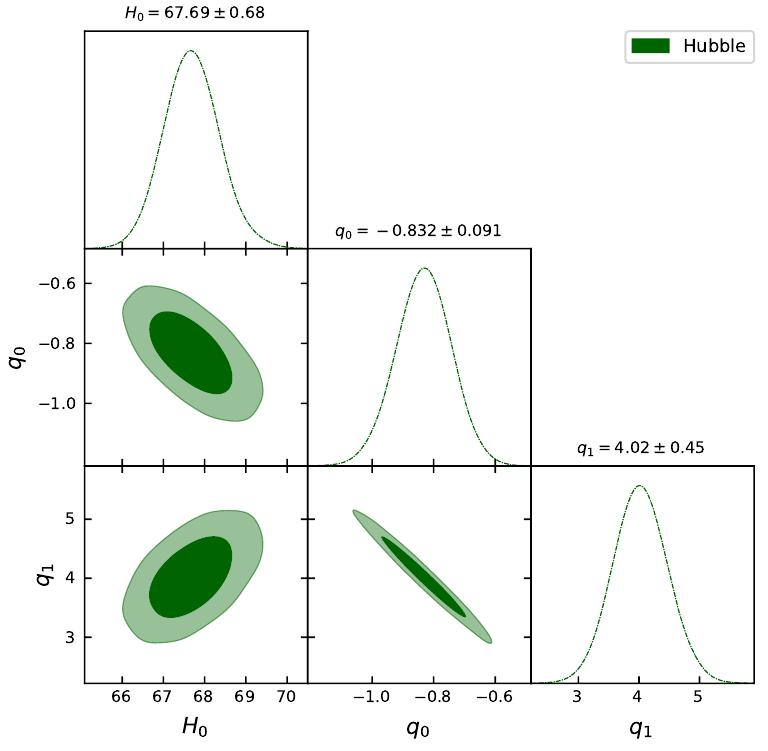
Figure 1. The marginalized constraints on the coefficients in the expression of Hubble parameter, H ( z ) , in Equation (13) are shown by using the Hubble sample